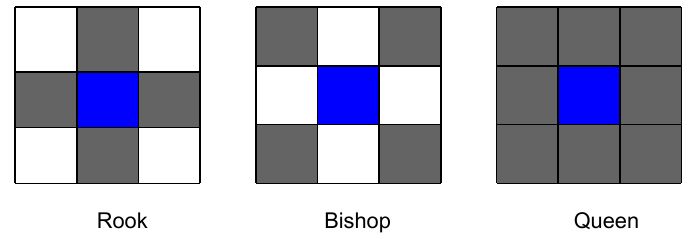
Figure 4. Spatial contiguity